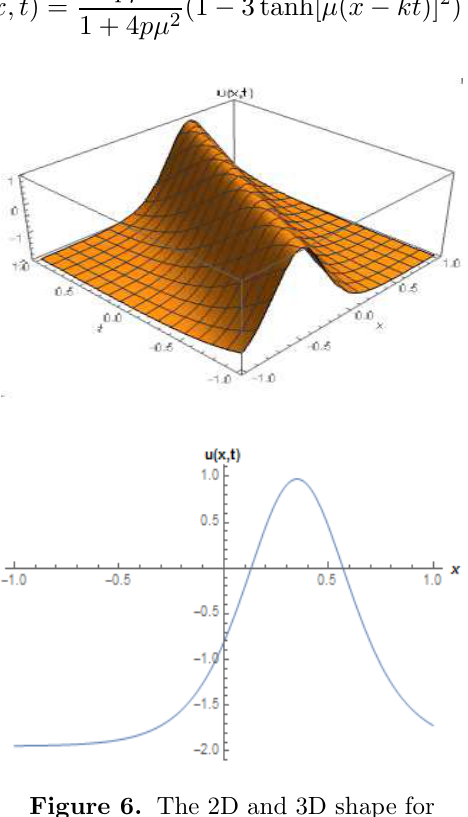
Figure 5. The 2D and 3D shape for the Eq. (18) with the values k = 0 . 005, µ = 3, c 0 = 1, 0 < t < 2 and t = 0 for the graphic of 2D.